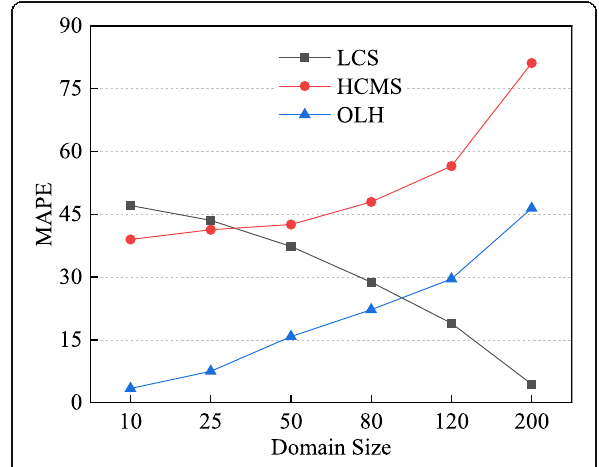
Fig. 6 The effects of different domain size